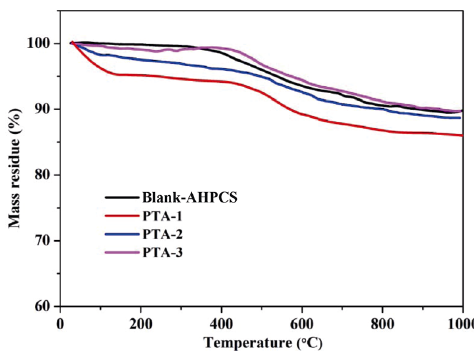
Fig. 3 TGA curves of blank-AHPCS and single-source-